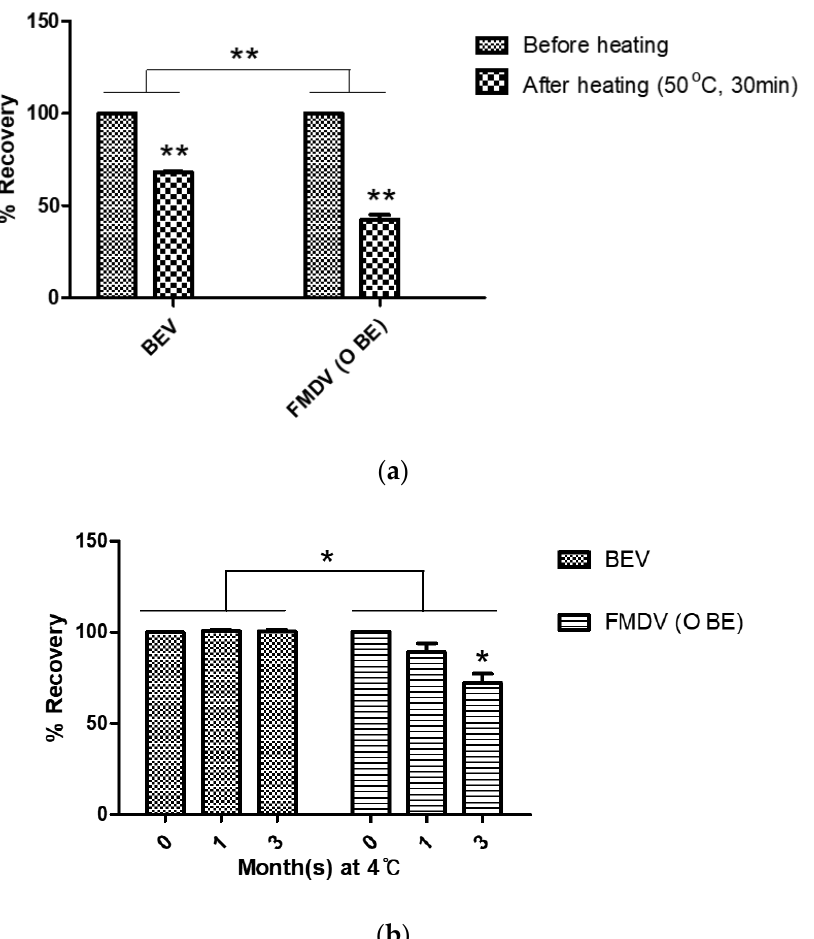
Figure 5. Stability of BEV as an FMDV surrogate for quantification standard. ( a ) The accelerated stability test results by heating at 50 °C for 30 min. ( b ) The long-term preservability test results by maintaining each viral antigen at 4 °C for 3 months. Initial content before heating or storage was set as 100%. * p < 0.05, ** p < 0.01. Abbreviations: BEV, bovine enterovirus.